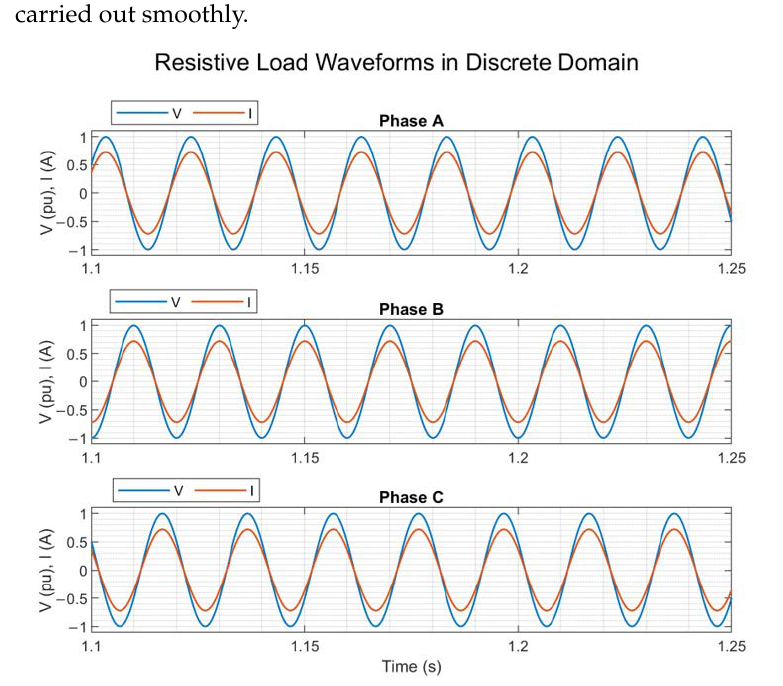
Figure 5. Instantaneous three-phase voltage/current waveforms for a resistive load connected at the interface bus in discrete domain. Represents in-phase synchronization with no undesired phase